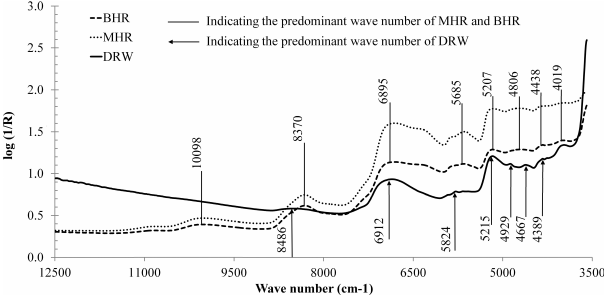
Fig. 2. Initial NIR spectra of BHR, MHR and DRW obtained using an FT-NIR spectrometer over the wave number region 12,500 – 4,000 cm (cid:1) 1 .